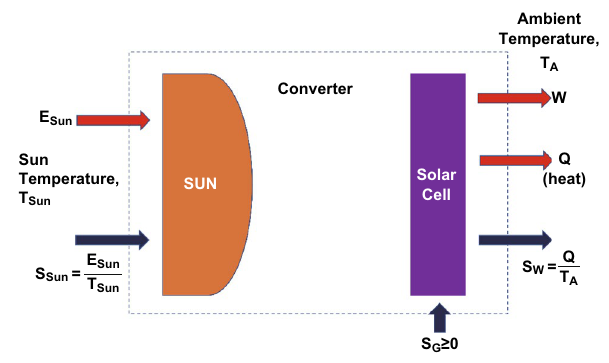
Fig. 2 Schematic sketch of a solar cell represented by a Carnot reversible heat engine